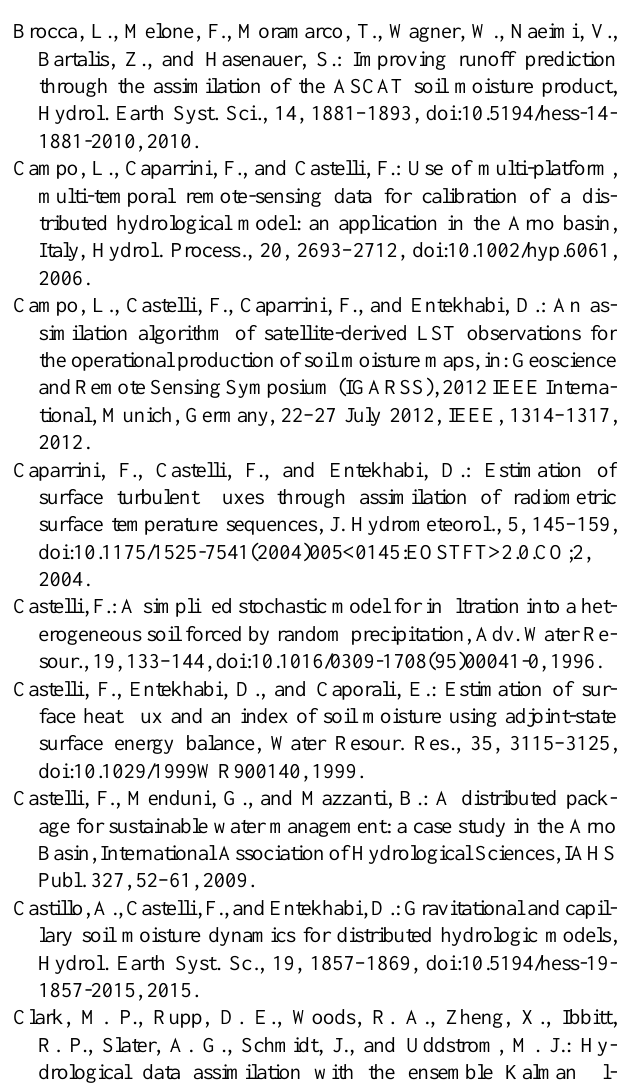
Figure 8. Flow peak versus precipitation volume at the avail- able measurement stations for the test event of LST assimilation. Acronyms in the legend maintain the same meaning of Fig.